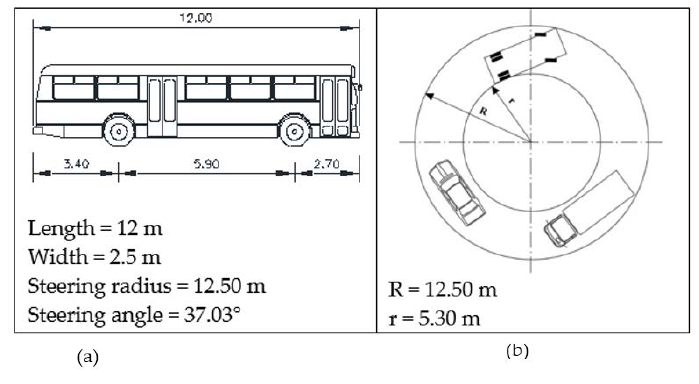
Figure 3. ( a ) Italian bus. ( b ) Curve inscription